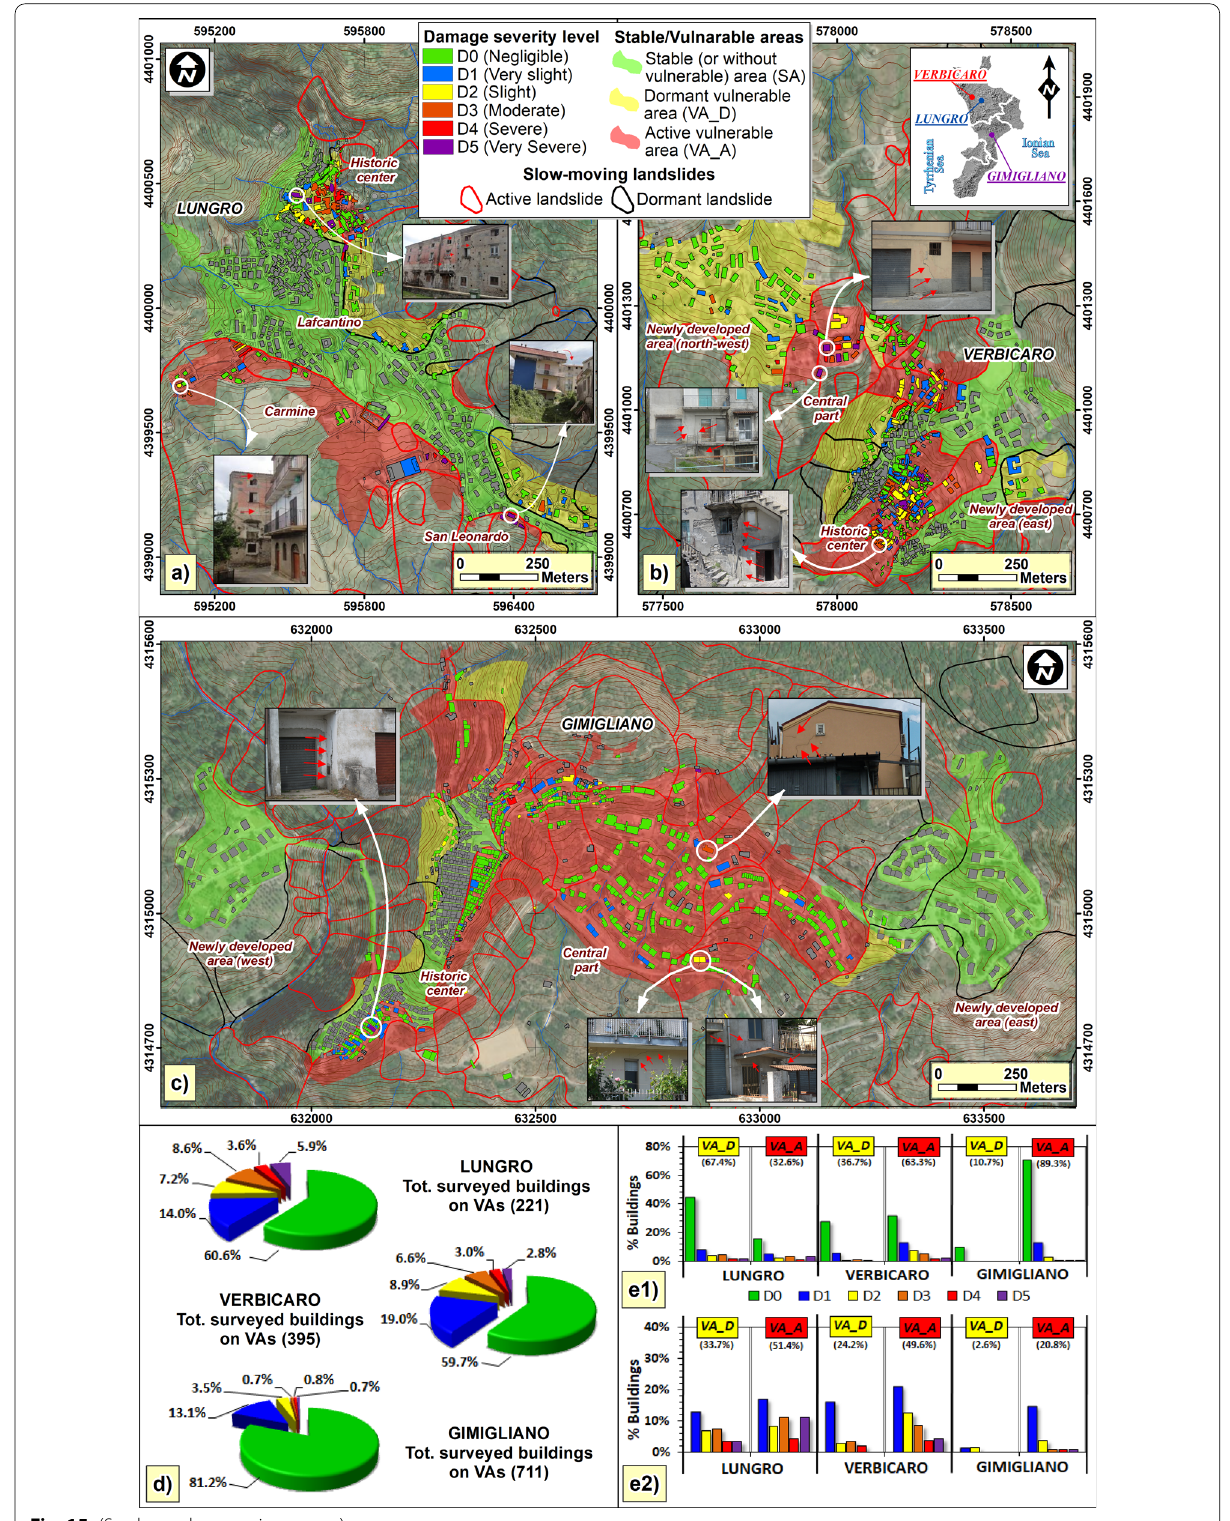
Fig. 15 (See legend on previous